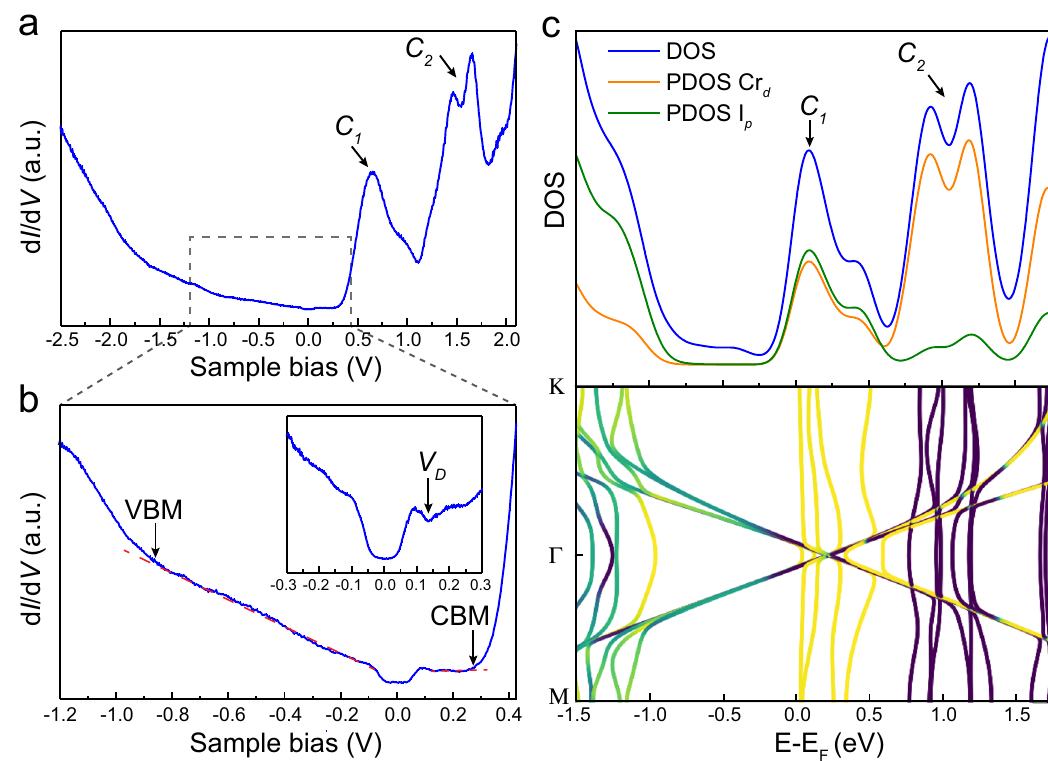
Fig. 2 The electronic structure of G/CrI 3 . a The d I /d V spectrum of G/FL-CrI 3 /Gr taken in a large sample bias window ( − 2.5 V ≤ V s ≤ 2.1 V). Two prominent double-peak features are indicated by C 1 and C 2 , respectively. b The d I /d V spectrum of G/FL-CrI 3 /Gr taken in a small sample bias window ( − 1.2 V ≤ V s ≤ 0.42 V). The band edges are indicated by VBM and CBM. The inset shows the d I /d V spectrum near the Fermi level ( − 0.3 V ≤ V s ≤ 0.3 V). The local conductance minimum is indicated by V D . c Calculated density of states (DOS) and band structure of G/ML-CrI 3 using Hubbard U = 0.5 eV. Both DOS and the projected DOS (PDOS) on iodine p orbitals and chromium d orbitals are shown. The color-coding in the band structure indicates the expectation value of spin S z with yellow and purple corresponding to spin-up and -down,